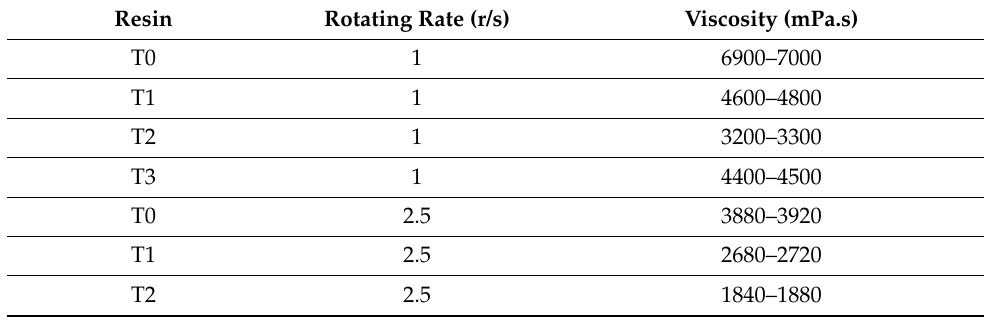
Table 2. Viscosity variation for the four formulations